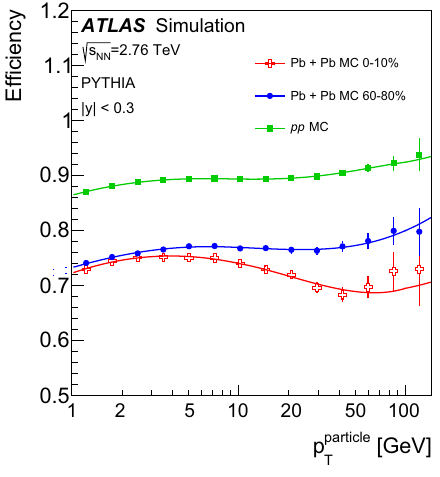
Fig. 1 The tracking efficiency evaluated in simulation for particles > 100 GeV as a function of truth charged-particle in jets with p jet T transverse momentum, p particle , for jets with | y | < 0 . 3 ( left ) and T